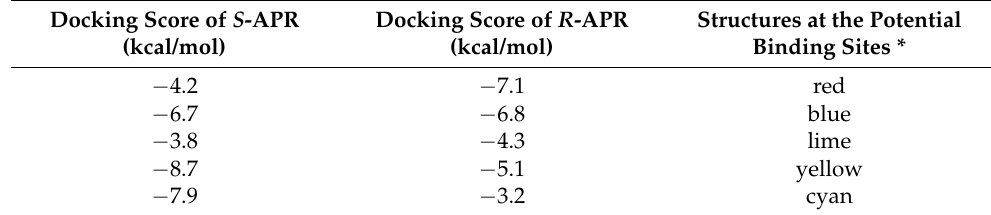
Table 4. Docking scores of APR at potential human serum albumin (HSA) binding